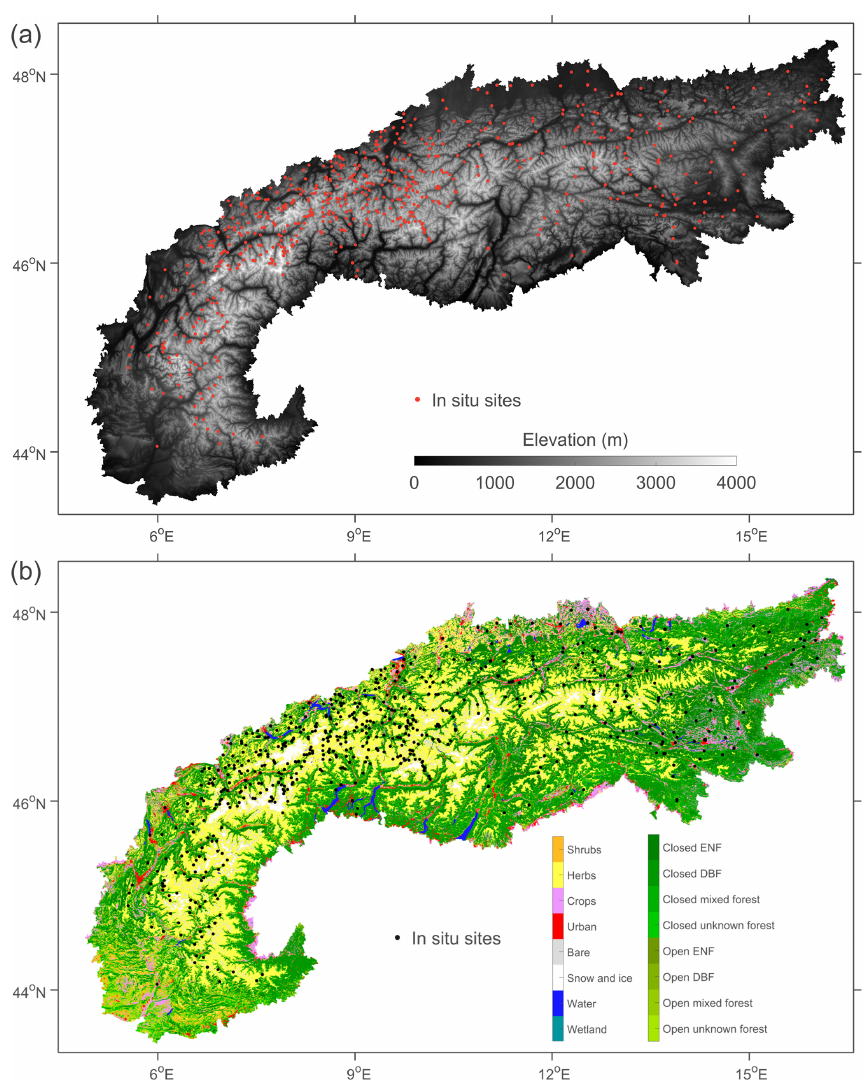
Figure 2. The in situ measurement locations within the European Alps on top of (a) elevation (m) and (b) land cover class (–). ENF stands for evergreen needleleaf forest, DBF for deciduous broadleaf